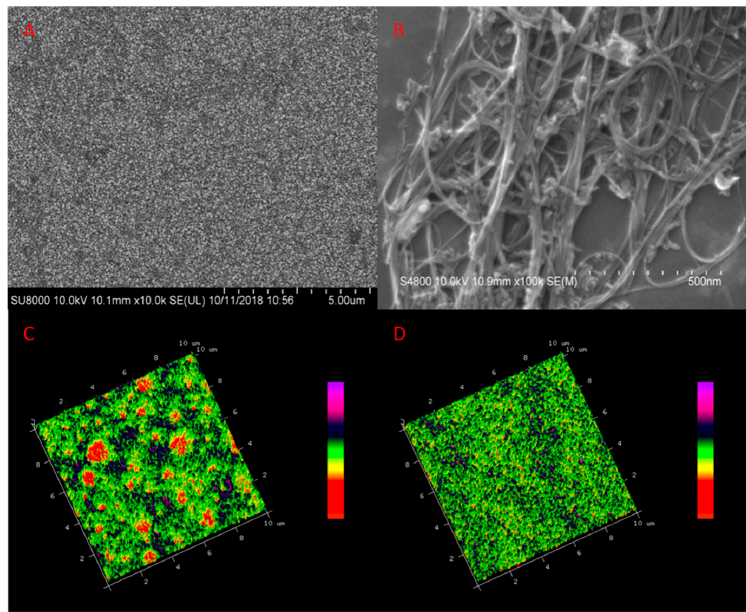
Figure 1. SEM images of the ( A ) AuNPs and ( B ) SWNTS; AFM images of AuNPs/cSWNTs/CS ( C ) and T-2-OVA-cSWNTs/CS/AuNPs ( D ). T-2-OVA-cSWNTs/CS/AuNPs ( D